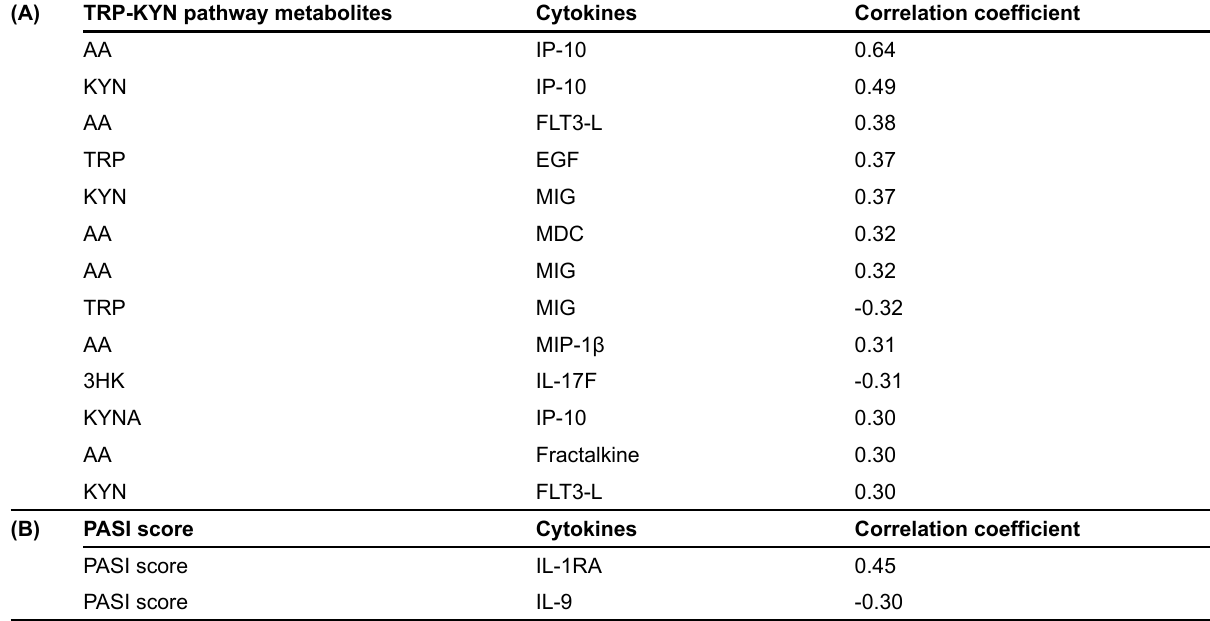
Table 5. Pearson’s correlation coefficients (|r| > 0.3) between the TRP-KYN pathway metabolites and cytokine levels (A) and between PASI score and cytokine levels (B) in PSOs (A) TRP-KYN pathway metabolites